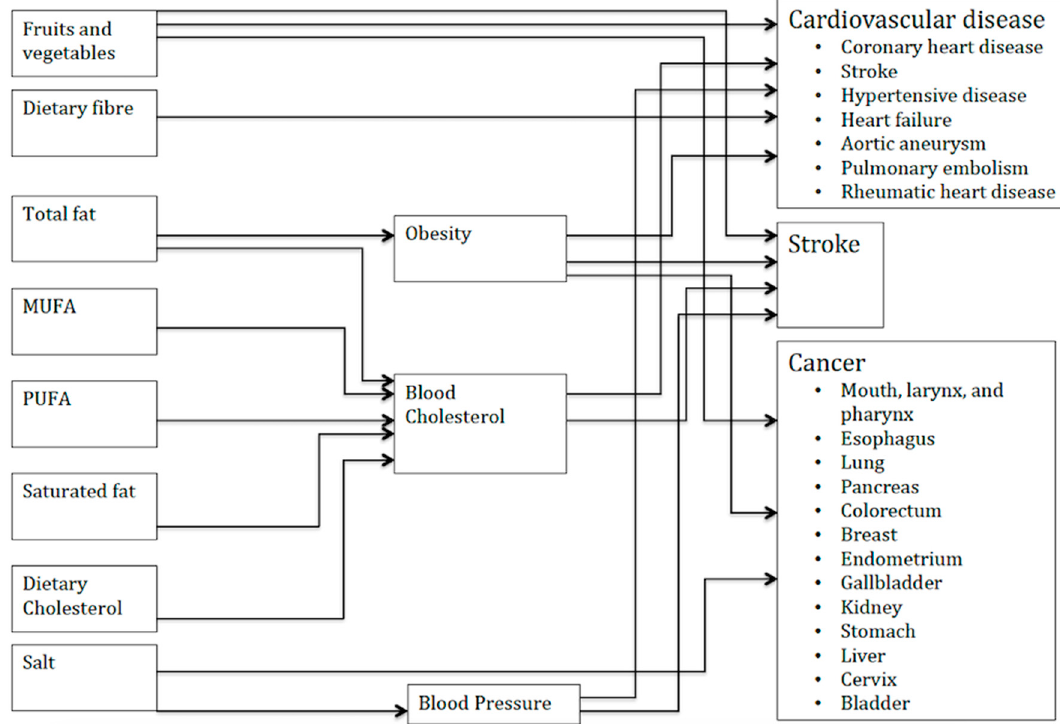
Figure 1. Conceptual framework for the Preventable Risk Integrated Model (PRIME).